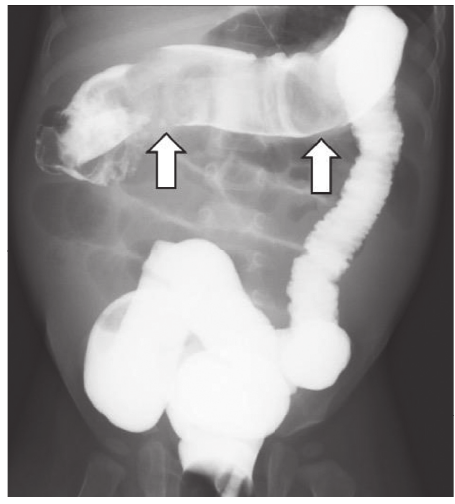
Figure 3: A gastrografin enema examination revealed expansion failure of the descending colon and the presence of impacted fecalomas in the transverse colon (arrows), which could not be resolved by colonic